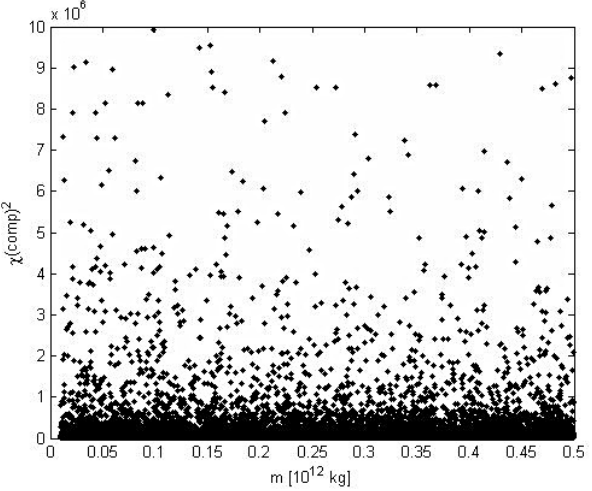
Fig. 4. χ(dg) 2 distribution against the mass component m relative to the 28645 Monte Carlo samples.